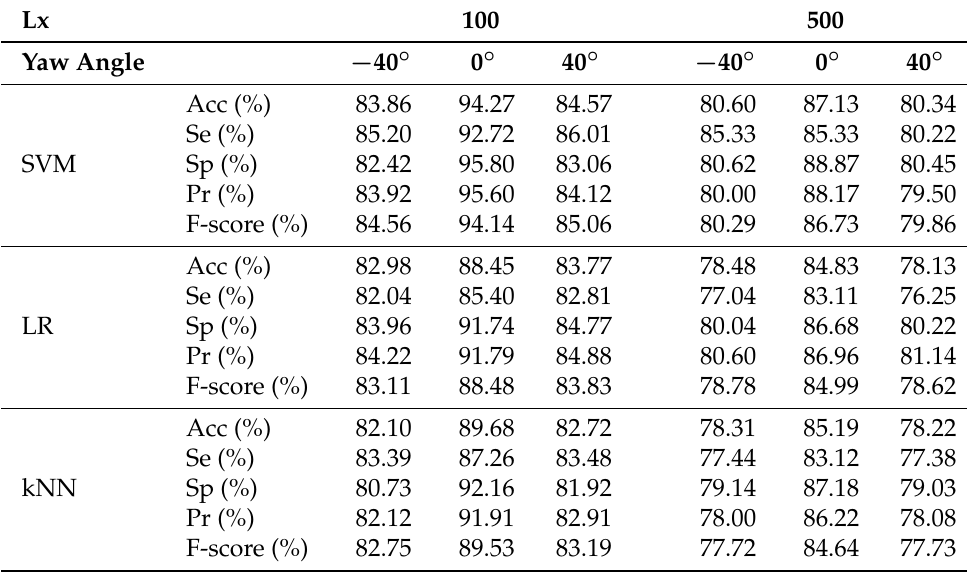
Table 4. Facial expression classification results obtained at varying of three different classifiers (SVM, LR and kNN), two lighting conditions and three yaw angles.